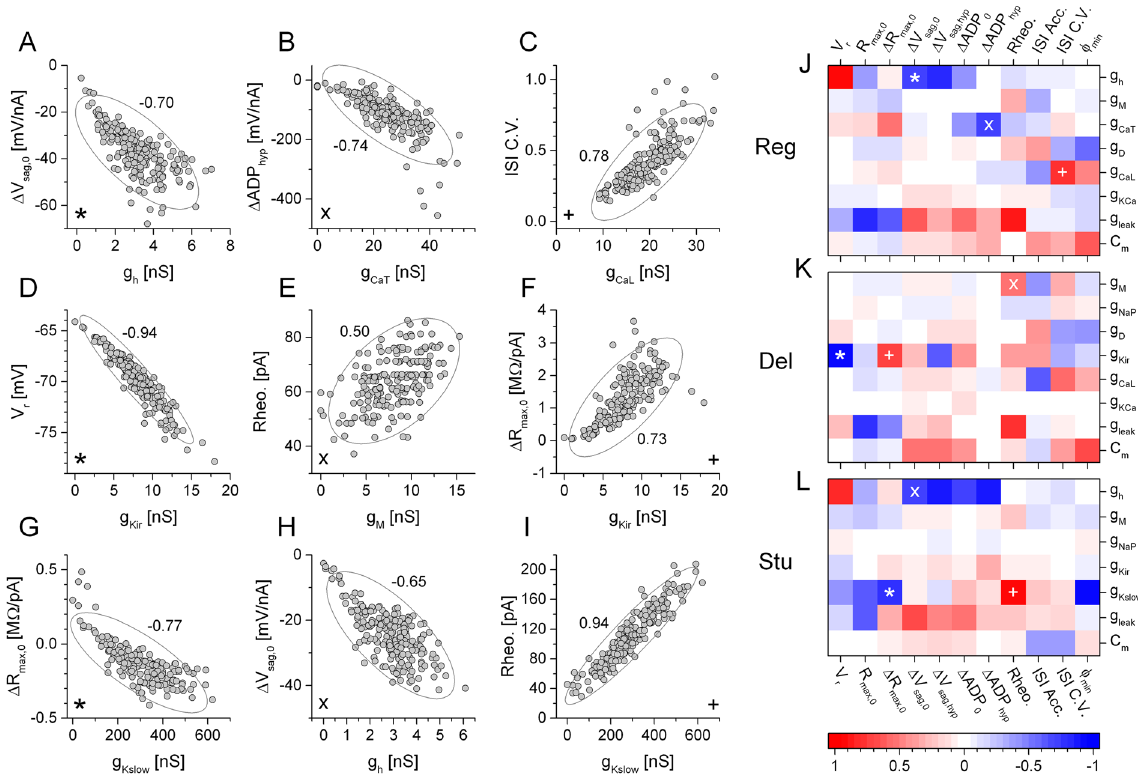
Figure 2. Maximal conductances of specific voltage-activated membrane currents and physiological parameters of the model neurons are correlated. ( A – I ) Selected physiological parameters are plotted against the maximal conductance of a voltage-gated current present in the regular firing (top row), delayed firing (middle) and stuttering (bottom) type models. Confidence ellipses appearing in each graph were obtained by calculating Pearson correlation (Pearson-coefficients are shown next to the ellipses). The h-current has a clear effect in setting the magnitude of voltage sag ( A,H ), while K-currents have stronger role in regulating the resting membrane potential ( D ), and rheobase ( E,I ) of the model neurons. Color maps on the right depict the degree of Pearson-correlation between the intrinsic voltage-gated currents and 11 selected physiological parameters obtained from the current step data. Asterisks, crosses and plus symbols in the color maps indicate the corresponding scatter plots in ( A – I